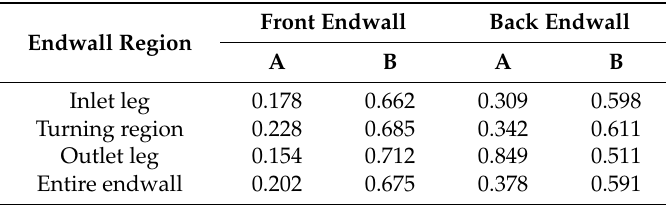
Figure 4. Normalized Nusselt number difference ratios for highlighting heat transfer disparities between front and back endwalls of twin-pass parallelogram channels with detached S-ribs and 90° ribs [18]. Table 2. Coefficients A and exponents B in heat transfer correlations.